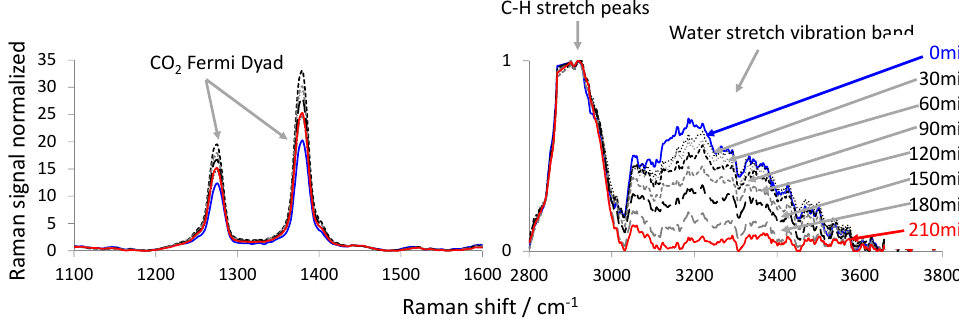
Figure 4. Temporal series of the processed Raman spectra acquired with the 785 nm excitation Raman sensor during an example drying experiment of a slice of persimmon.